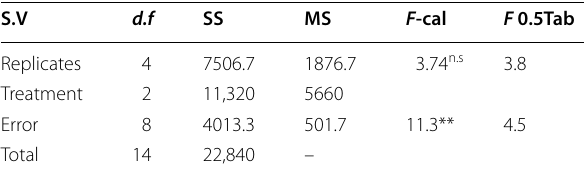
ns, non-significant; **Highly